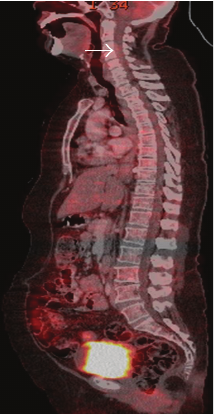
Figure4:PETimageshowingmoderatelyFDGavidintraduralmass lesion